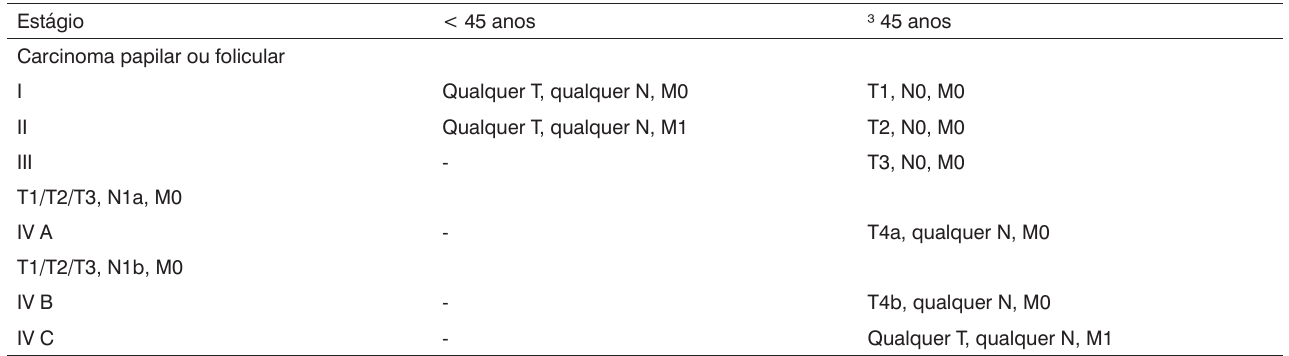
Tabela 2. Estadiamento dos tumores diferenciados de